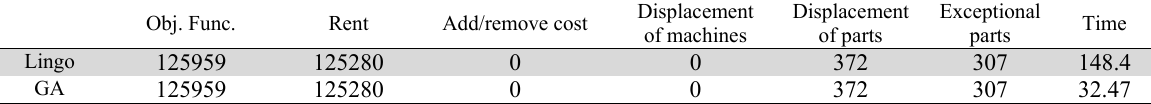
Add/remove cost Rent Obj.